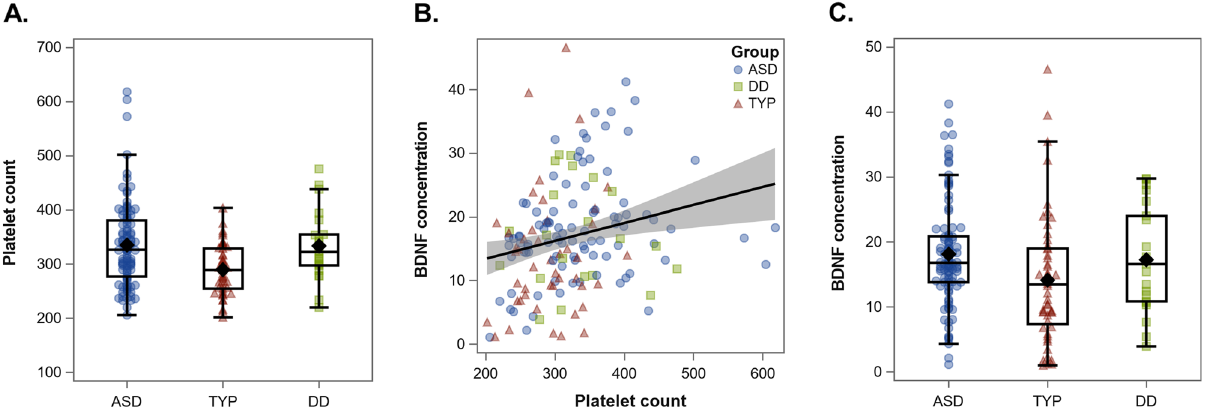
Figure 1. Plots of raw data. ASD autism spectrum disorder, TYP typical development, DD developmental delay. Panel ( A ) shows platelet count by group. Test statistics for pairwise comparisons were as follows: ASD:TYP, t(157) = 4.17, p < 0.0001; ASD:DD, t(157) = 0.06, p = 0.096; DD:TYP, t(157) = 2.75, p = 0.007. Panel ( B ) shows the correlation between platelet count and BDNF concentration (ng/mL) (r = 0.23). This correlation increased after excluding extreme values of platelet count and/or BDNF concentration (ng/mL). Panel ( C ) shows BDNF concentration (ng/mL) by group. See Table 2 for associated inferential statistics.